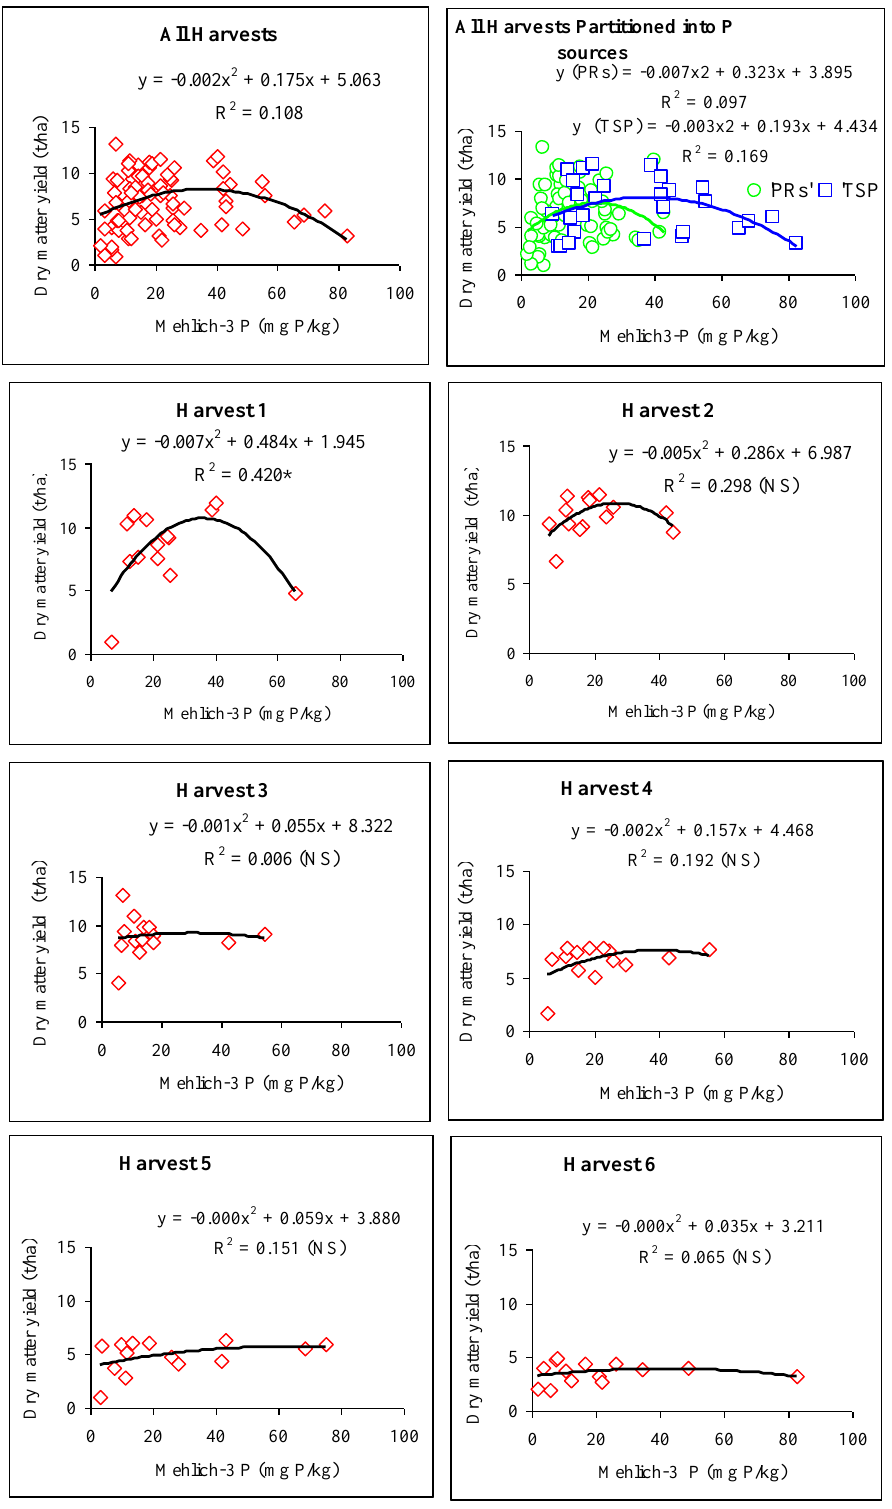
FIGURE 3B . Relationship between Meh3 extractable P and Setaria DMY for all harvests, all harvests partitioned into different P sources, and harvests 1–6. NB: * and ** denote significance at 5 and 1%, respectively. NS denotes not